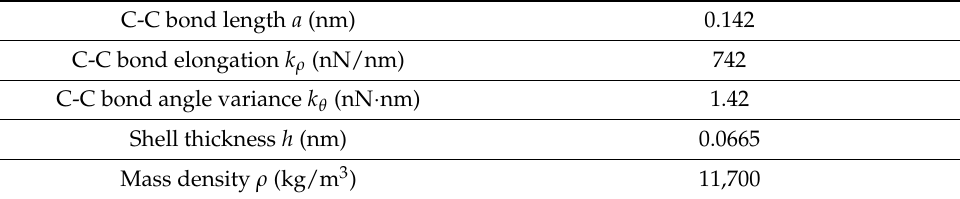
Table 1. Mechanical parameters adopted in the anisotropic elastic continuous shell model